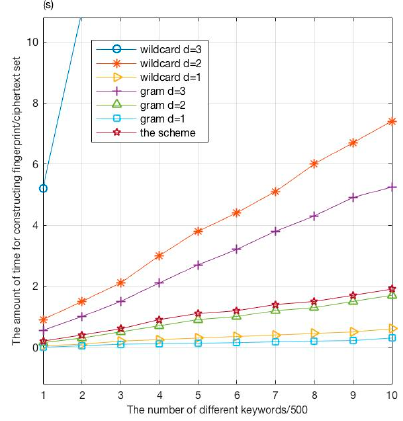
Figure 5. Time consumption for the construction of the finger/cipher-text fuzzy set.